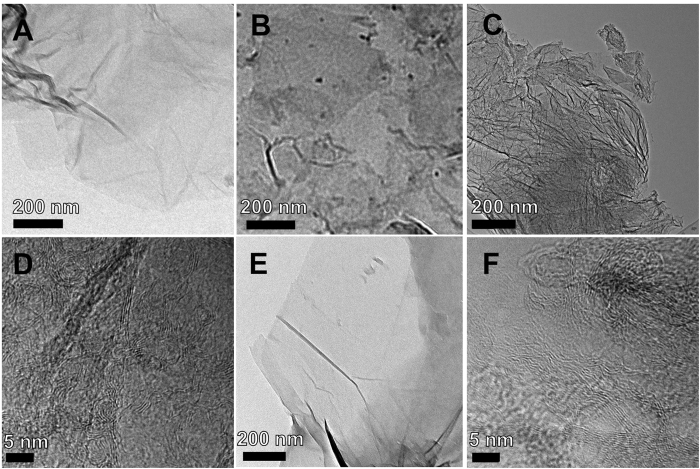
TEM images of GO (A), GOGA(B), rGO (C) and rGOGA (E). High resolution TEM images of rGO (D) and rGOGA (F).